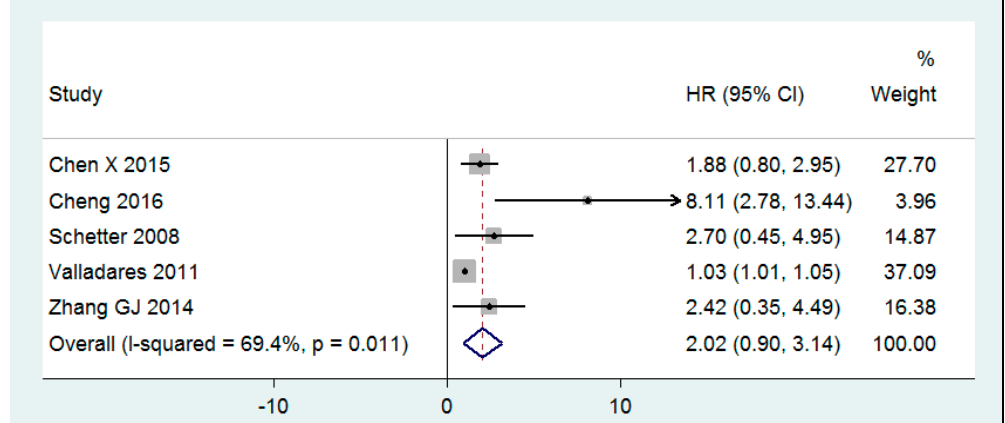
Figure 4. Forest plot for the meta-analysis of HR for OS evaluated by random effects analysis.